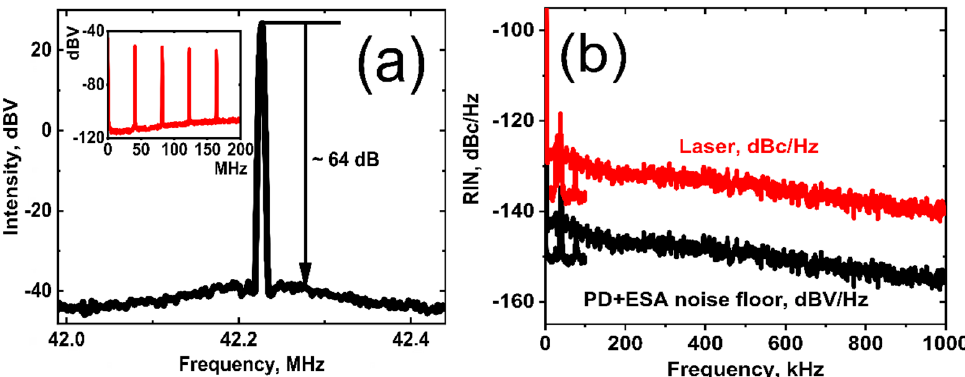
Figure 9. ( a ) The radio-frequency spectrum of the pulse train at the fundamental repetition frequency and in the range 30 kHz–200 MHz (inset). ( b ) RIN of the USP fiber laser and photodetector (PD) + ESA noise floor.